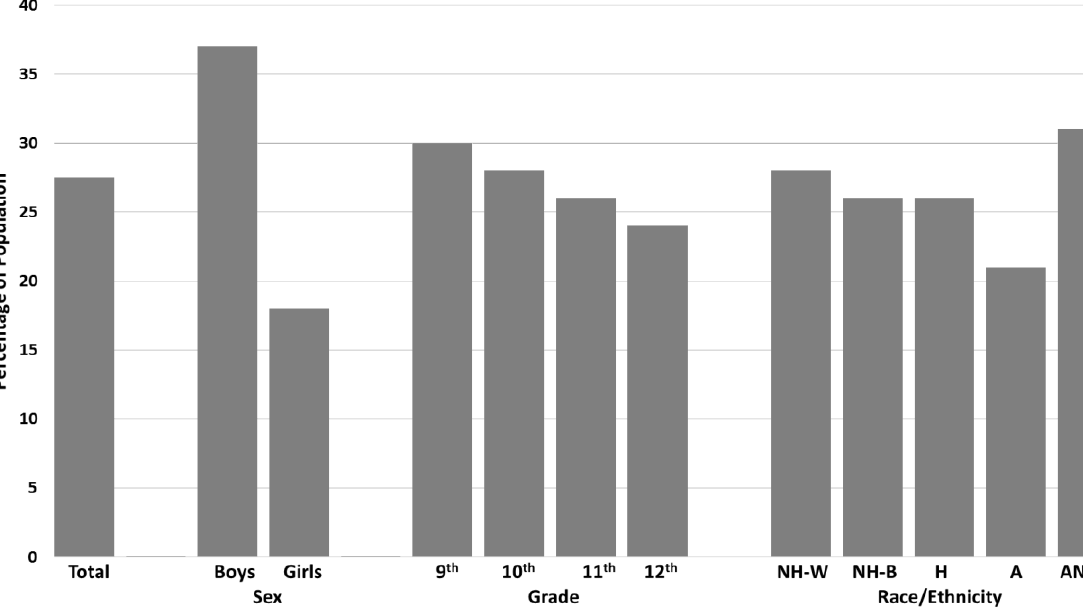
Figure C-5. Percentage of High School Students Meeting Aerobic Target Range,